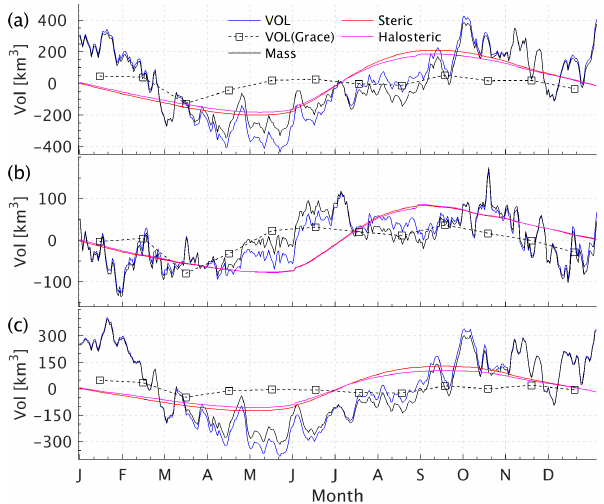
Figure 8. (a) Time series of total volume (VOL) anomaly in the Arctic Ocean (see Fig. 1 for the regions) and the contributions from mass changes (mass) and steric effects (steric). The halosteric com- ponent (halosteric) and the GRACE-observed mass component are also shown. Panels (b) and (c) show the corresponding values in (b) the deep basin ( > 500m) and (c) the shallow water ( < 500m).